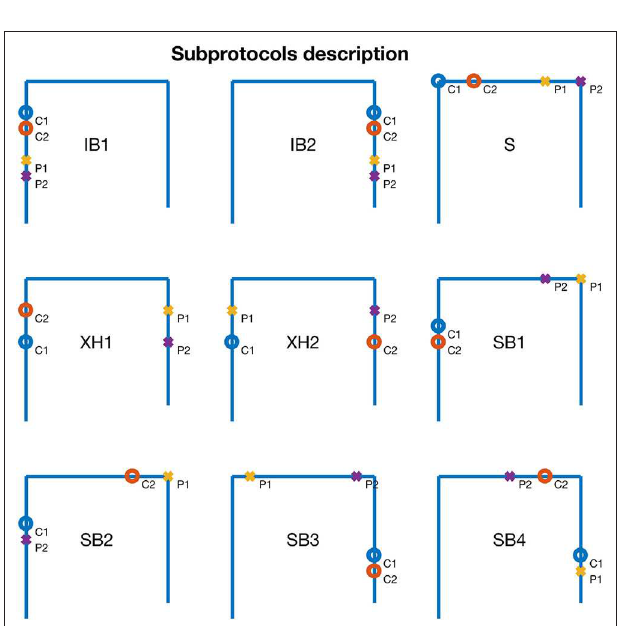
FIGURE 4 | Representation of the different subprotocols used during this study in boreholes and at the surface. For each subprotocol, current electrodes C1 and C2 and P1 and